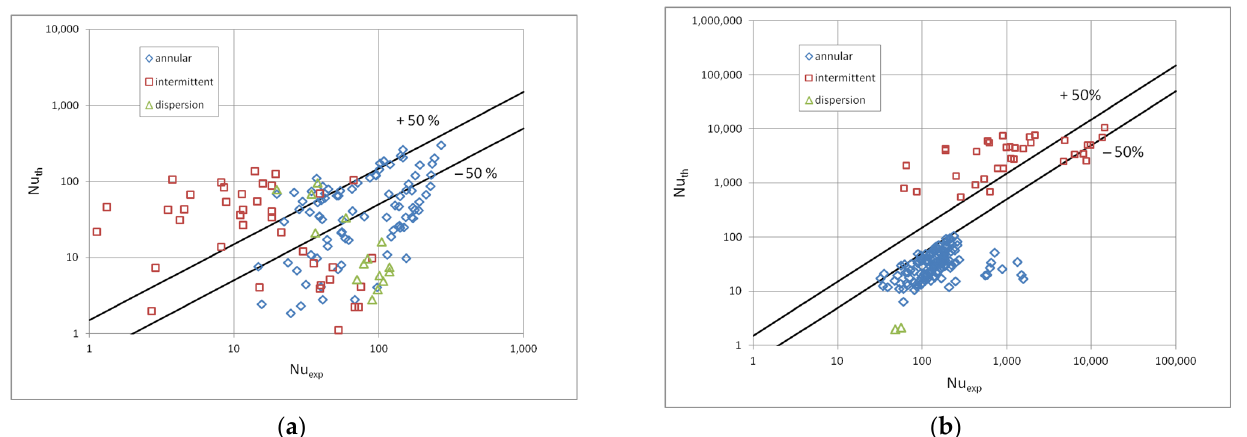
Figure 16. Comparison of the experimental condensation studies results of the refrigerant: ( a ) R134a, ( b ) R404a in mini-channels with calculations according to the author’s correlation (1) describing the heat transfer in terms of a stratified, intermittent and dispersive